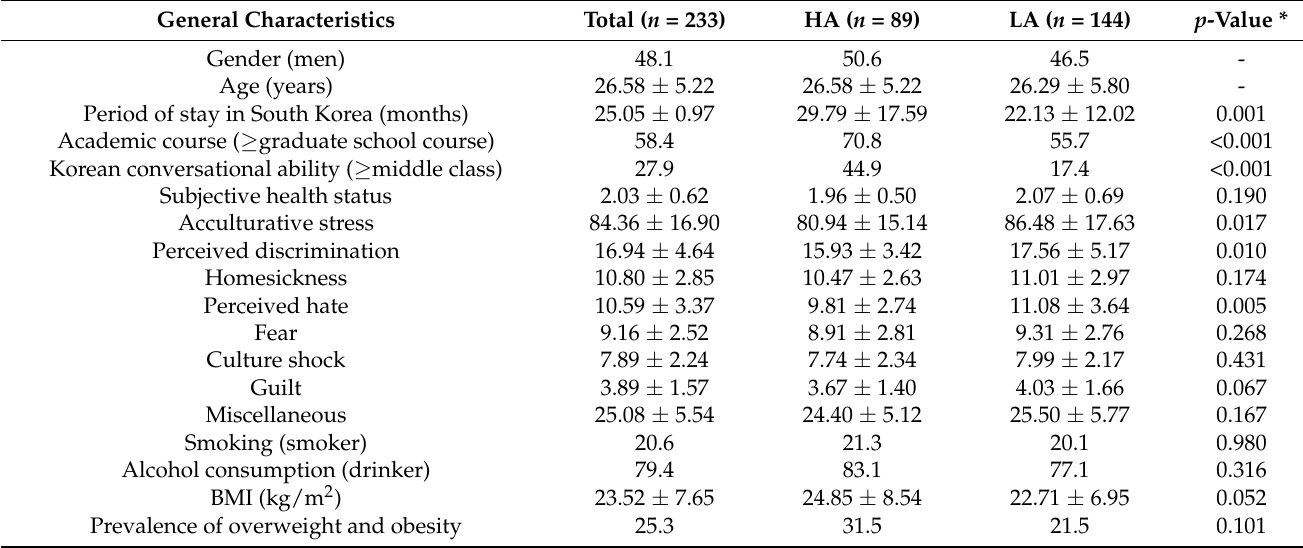
Table 1. General characteristics according to acculturative